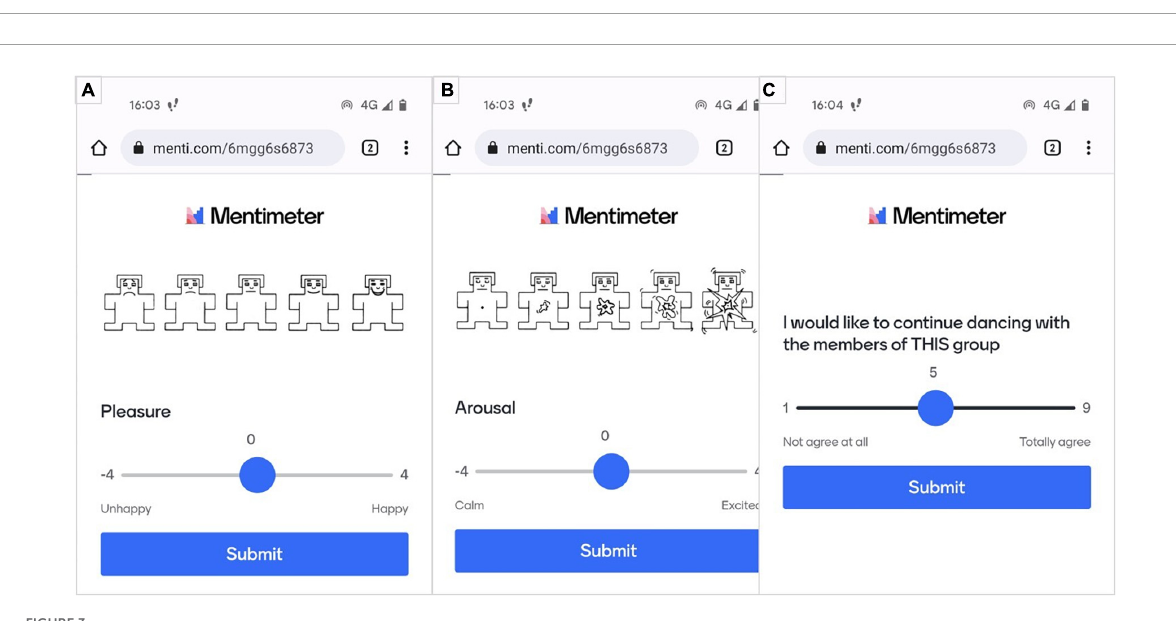
FIGURE3 Evaluation of emotional [ (A) pleasure; (B) arousal] and social (C) consequences after each performed